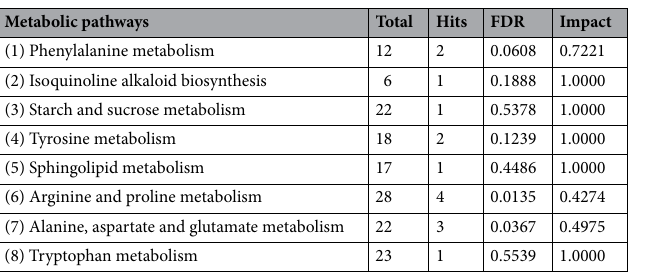
Table 2. List of metabolic pathways activated in the grains of T. controversa infected and non-infected.